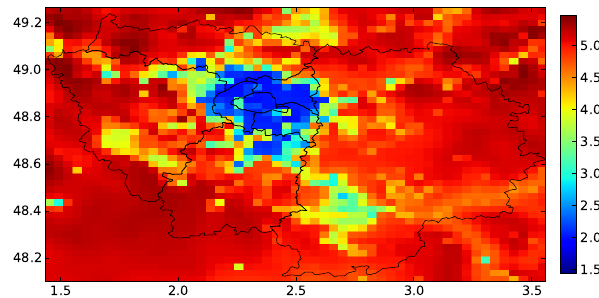
Figure 8. Spatial distribution of the annual mean deposition veloc- ity (mm s − 1 ) for 2011 in the Paris region. The coordinates indicate longitude (east) and latitude (north). The black lines indicate the French administrative counties (“départements”).